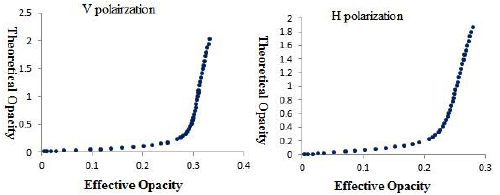
Figure3, The relationship between theoretical optical depth and effective one.